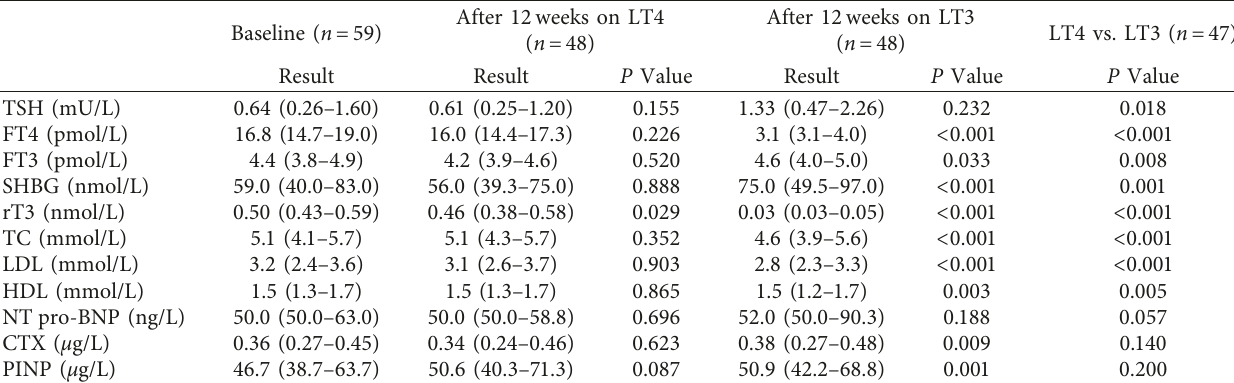
Table 2: Biochemical and hormonal parameters reflecting thyroid hormone signaling.